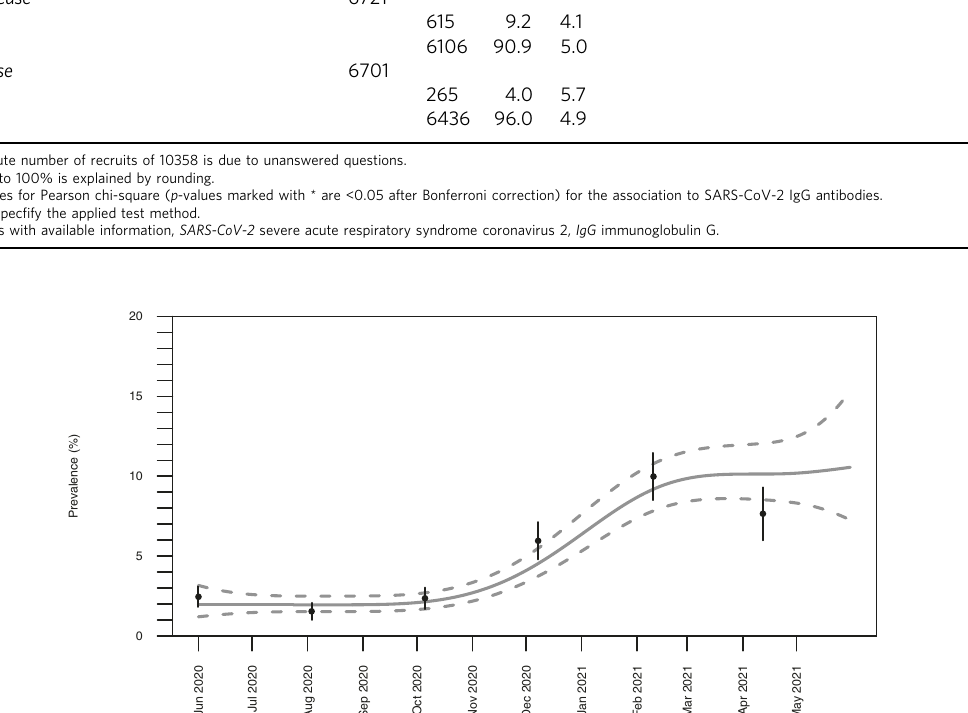
Fig. 2 Trends in SARS-CoV-2 seroprevalence from June 2020 to May 2021 in children in Germany. Two-month-average point estimates of the prevalence of Severe Acute Respiratory Syndrome Coronavirus 2 immunoglobulin G antibodies as determined by an enzyme-linked immunosorbent assay in blood samples from 10,358 paediatric study participants. The black dots display the respective point estimates of the prevalences and the wkiskers (lines at the black dots) the 95% con fi dence intervals of the point estimates. The predicted probability according to a b-spline regression model (grey solid line) with 95% con fi dence band (grey dashed